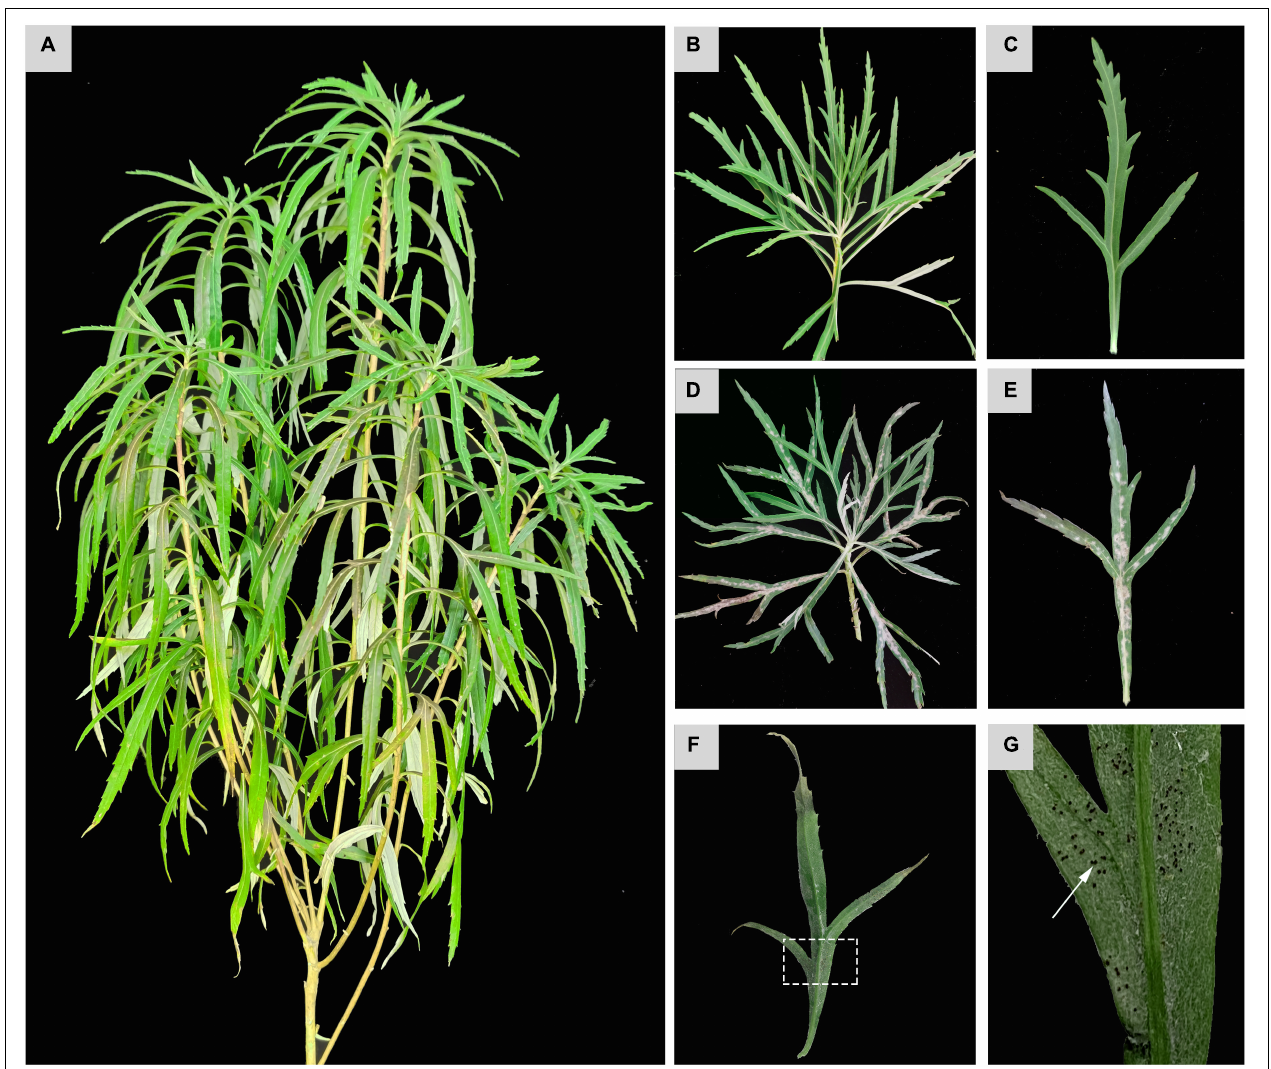
FIGURE 1 | Phenotypic observation of Golovinomyces artemisiae infection on Artemisia selengensis . Healthy A. selengensis (A) and partially enlarged images (B,C) . G. artemisiae -infected leaves (D,E) and chasmothecia on the surface (F,G) . Those areas indicated by the white dashed square and arrow represents the